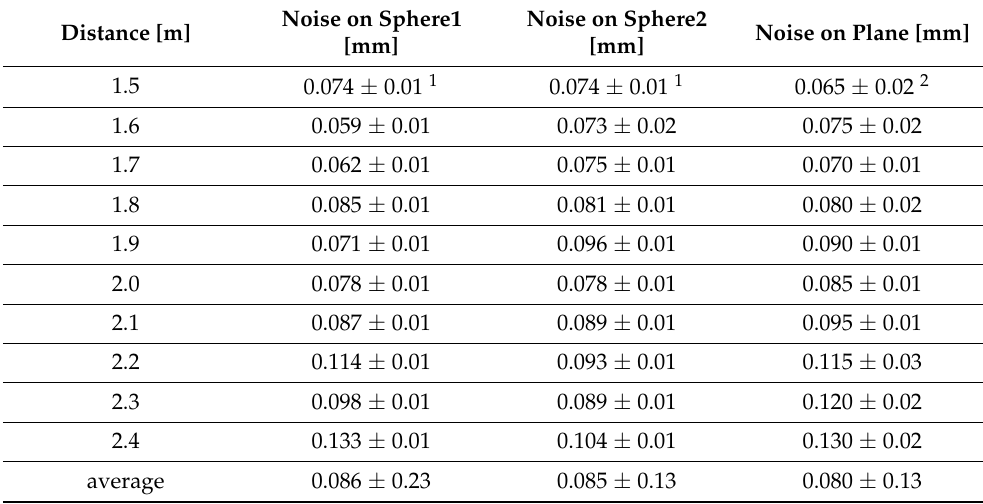
Table 2. Results of noise determination on sphere surfaces and plane normal depending on object distance; refinement does not have any influence on the noise values.